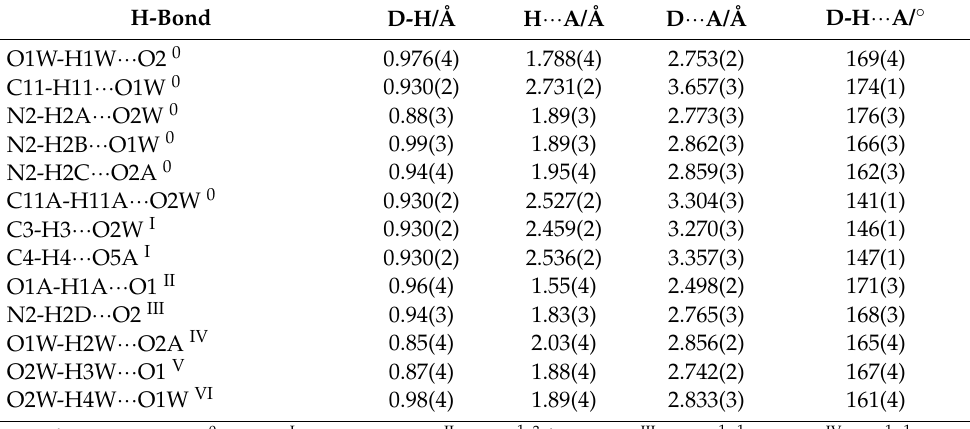
Table 1. H-bond geometry (D: Donor, A: Acceptor), as calculated by PARST [26].